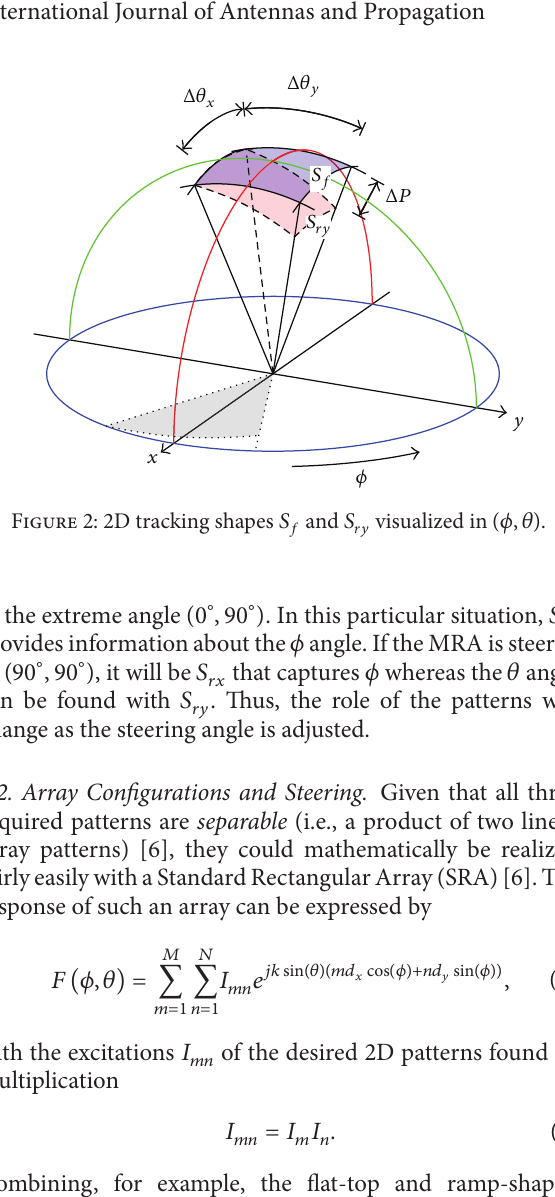
𝑓 pattern steered to